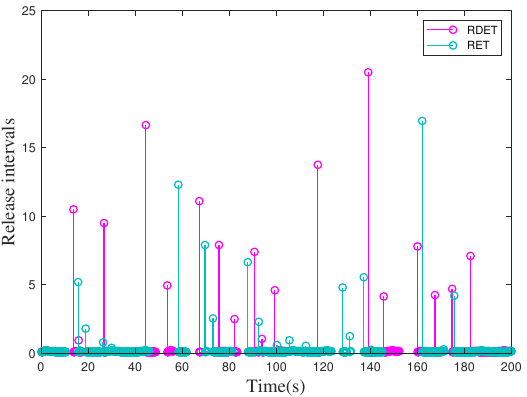
Figure 12. Triggered instants and release intervals under aperiodic DoS attacks.